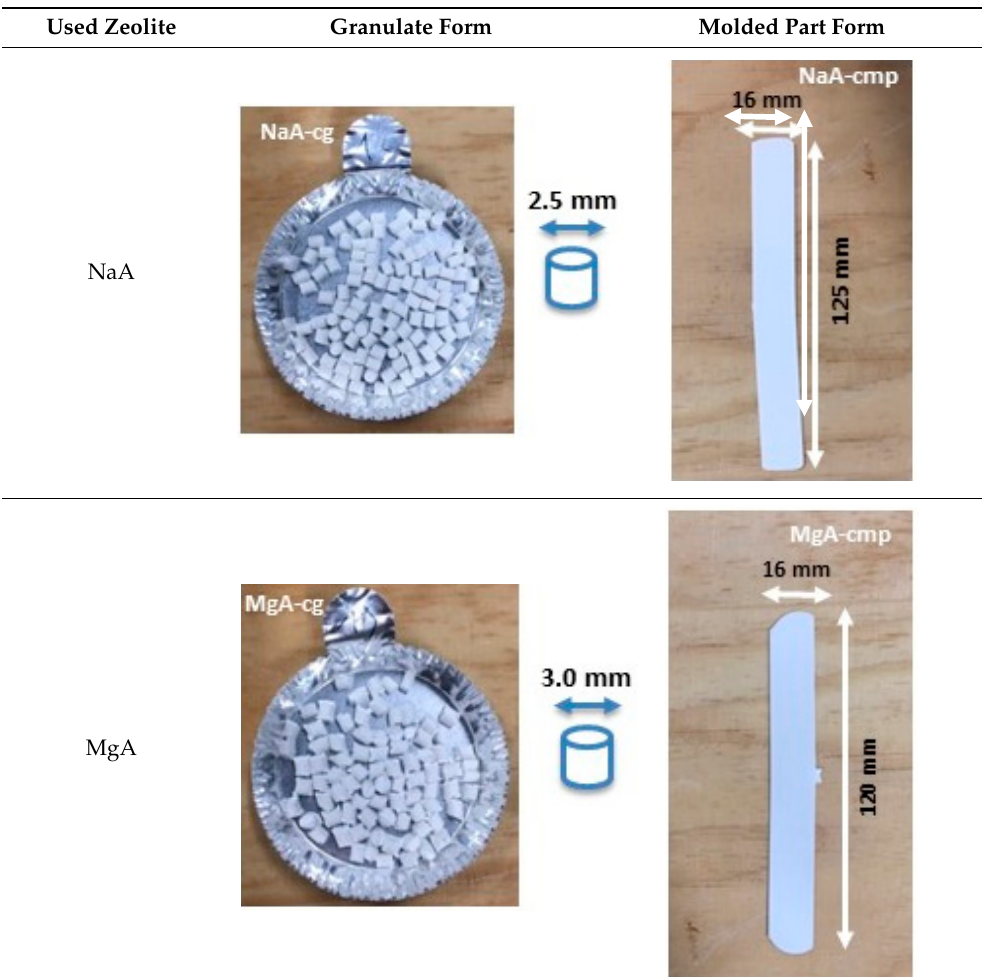
Table 3. Composite material samples containing NaA and MgA zeolite samples in both granulates and molded part forms.